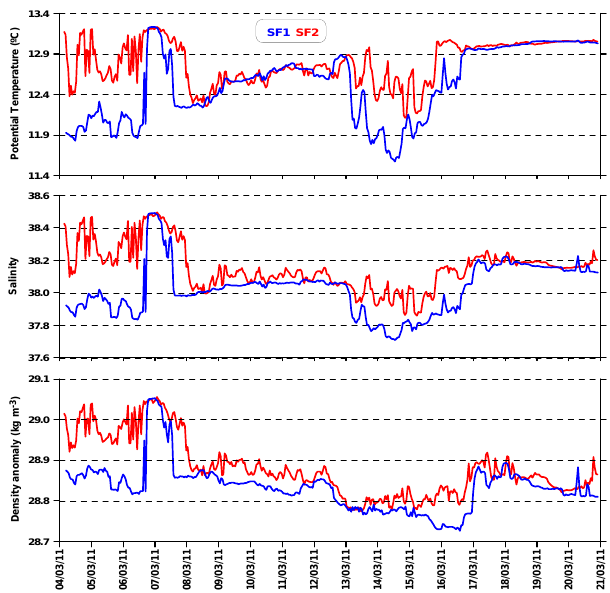
Fig. 9. Time series of potential temperature, salinity and density anomaly measured with a SBE 37-SMP probe attached 8mab in the two mooring lines deployed on the southern CCC